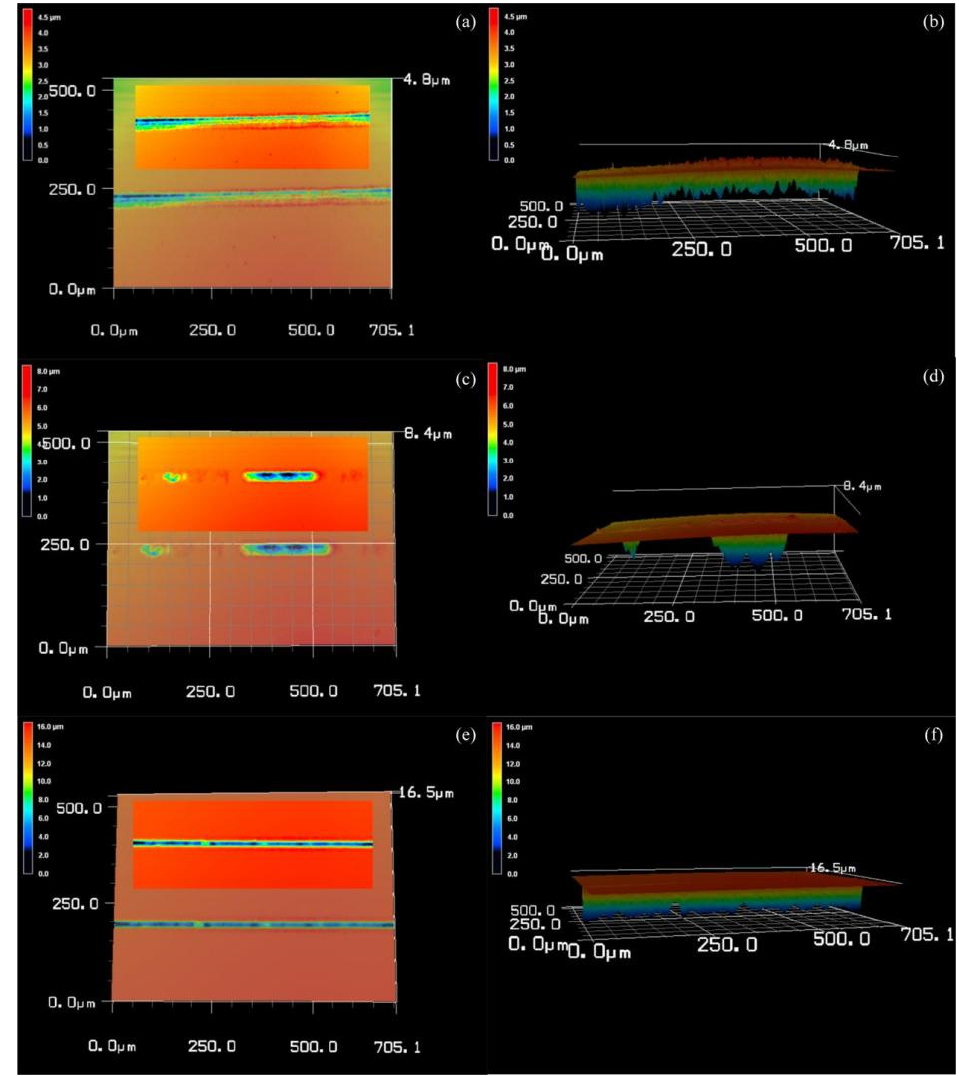
Figure 11. Maximum depths of microchannels under different liquid mediums: ( a , b ) deionized water; ( c , d ) 5.6 mol/L phosphoric acid solution; ( e , f ) absolute ethanol.